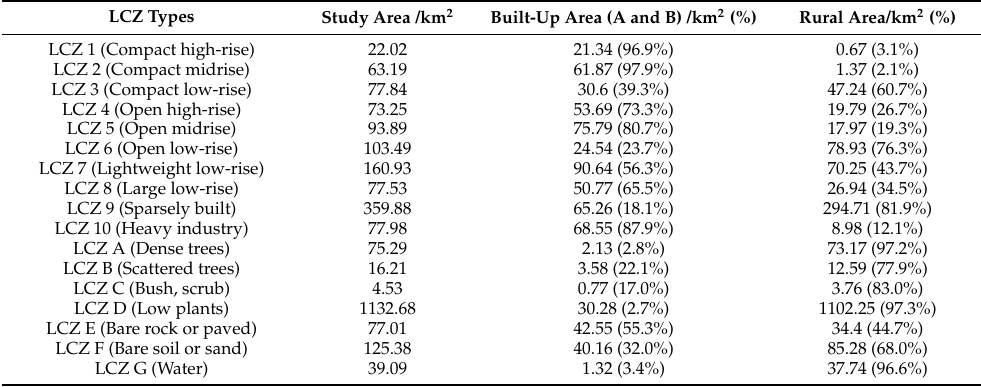
Table 2. The area of different LCZ types in the study area, built-up area and rural